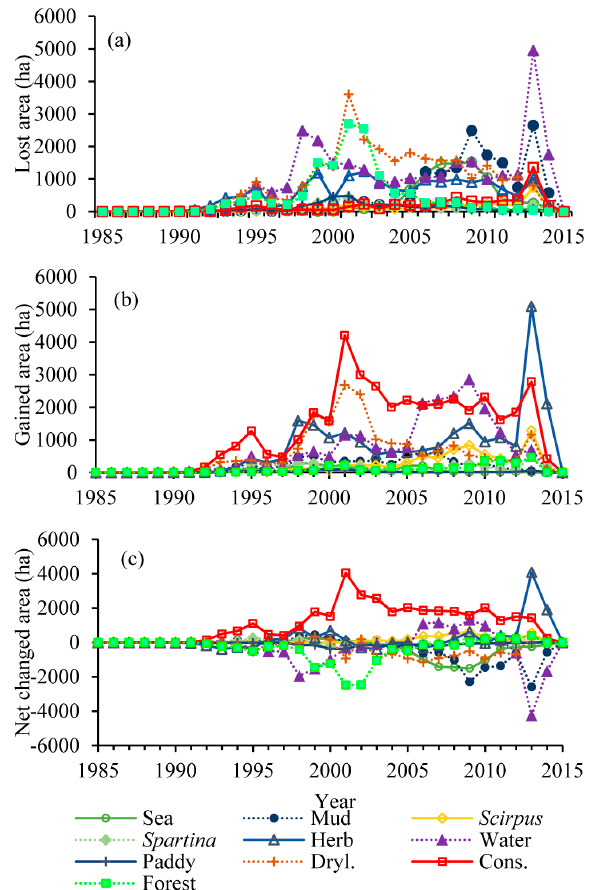
Figure 8. Annual change area of each land cover at Hangzhou Bay in Zhejiang Province, China, during 1987–2015. ( a ) lost area (area changed to other categories); ( b ) gained area (area changed from other categories); and ( c ) net changed area (note: Dryl., dryland; Cons., construction land).